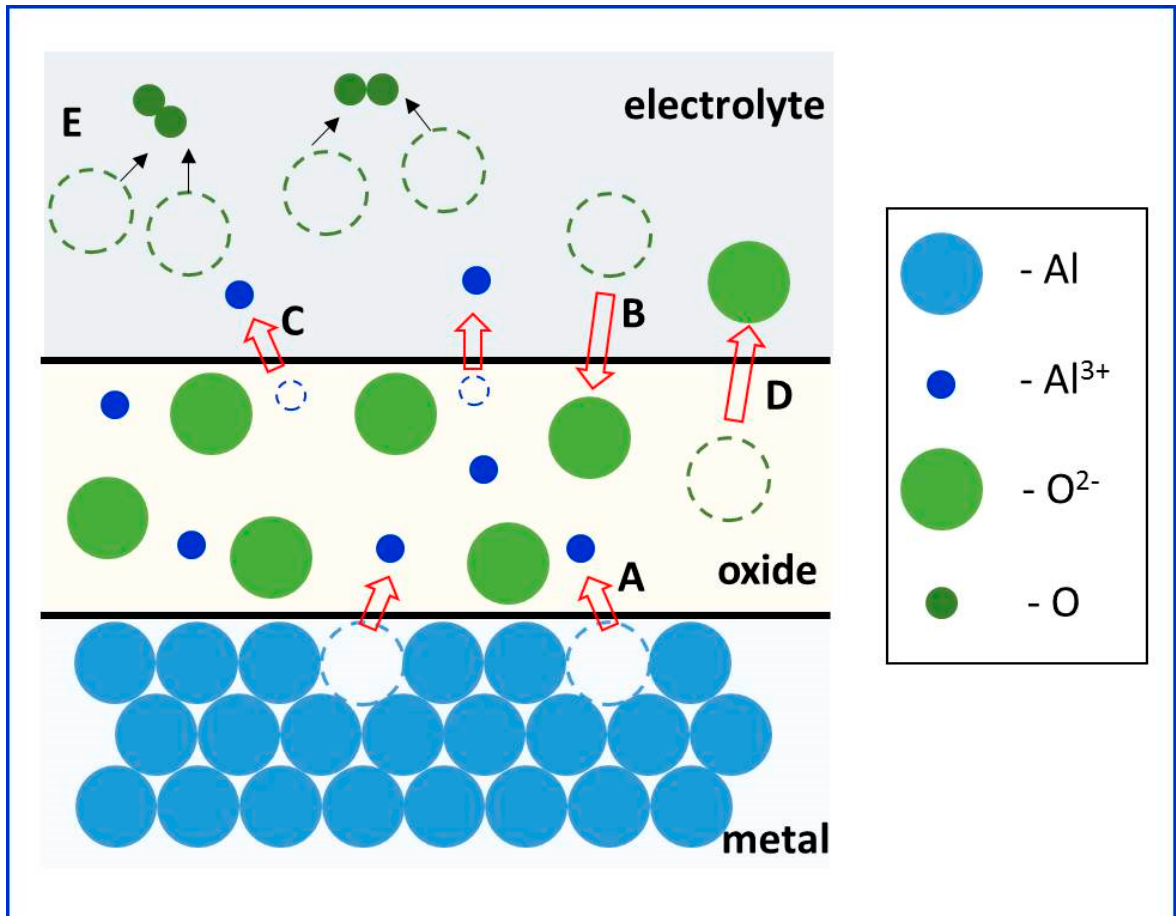
Figure 6. Schematic illustration of elementary reactions (10)–(16) taking place at metal/oxide and oxide/electrolyte interfaces. A—oxide formation at metal/oxide interface (10)–(11); B—oxide for- mation at oxide/electrolyte interface (12); C—direct cation ejection in the electrolyte (14); D—oxide dissolution (13); E—oxygen evolution (15).